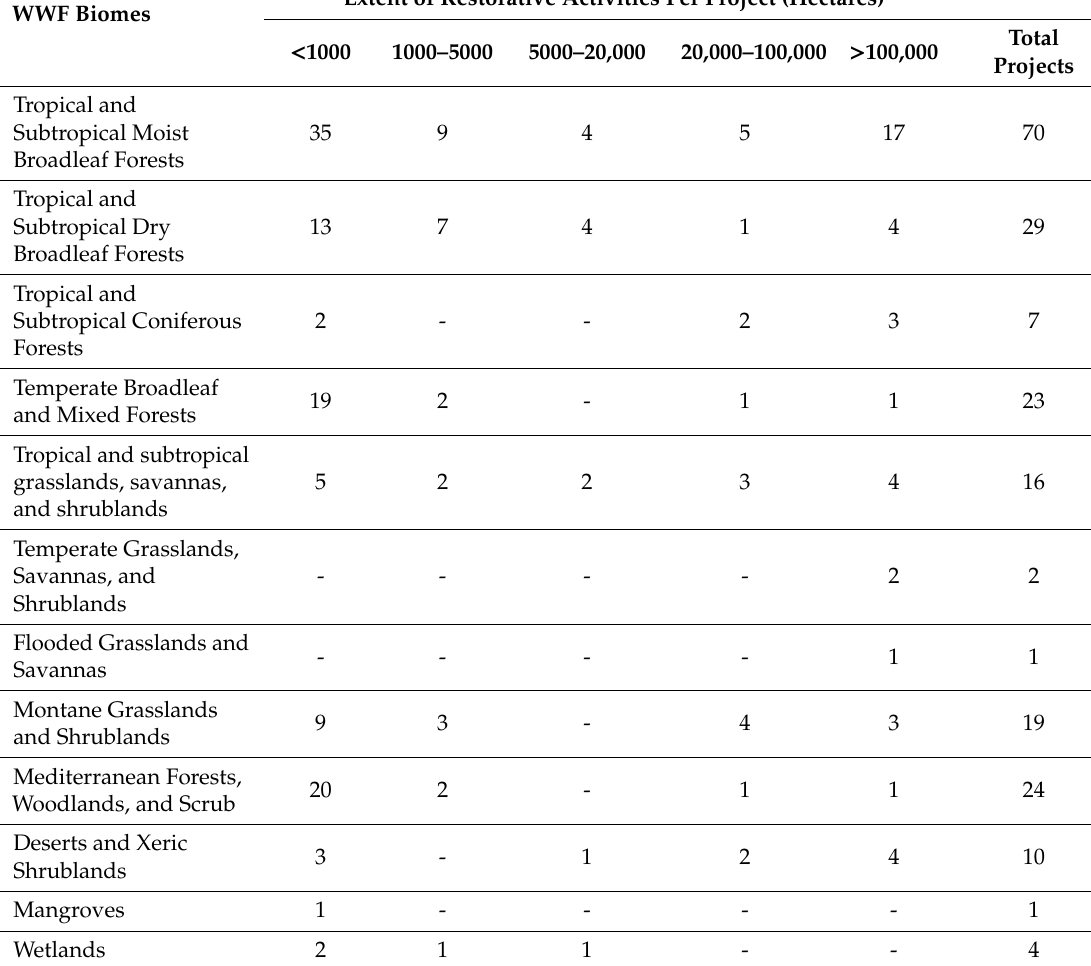
Table 2. Number of restoration projects within various World Wide Fund for Nature (WWF) biomes [34], sorted by project size. A project can cover multiple biomes.